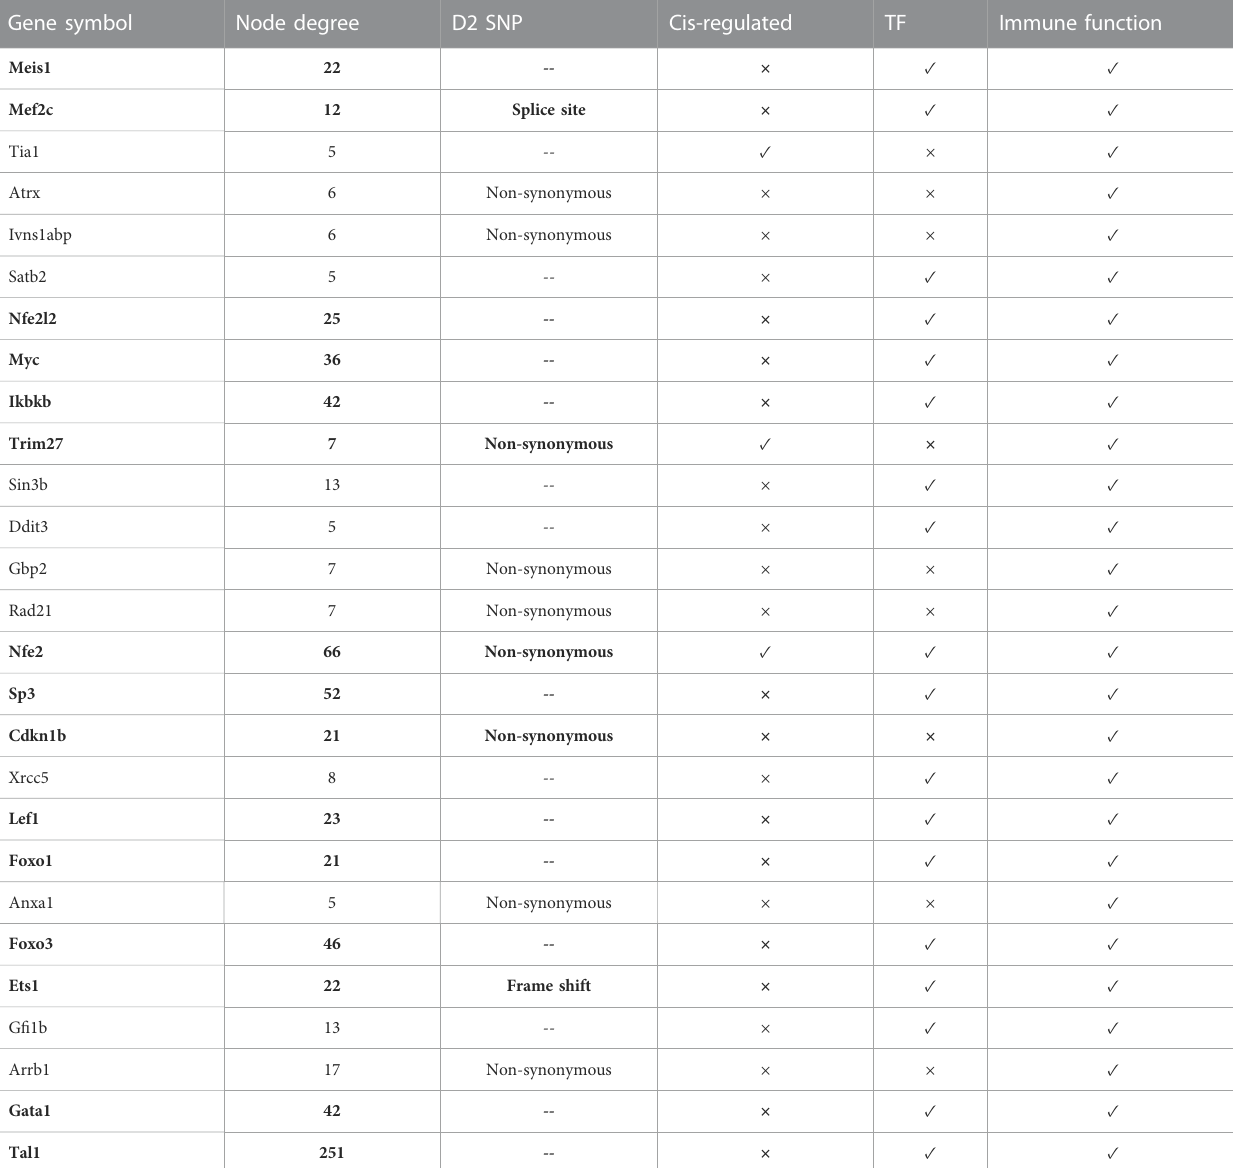
TABLE 1 Selected key genes with a node degree ≥ 5 in protein interaction network. Gene